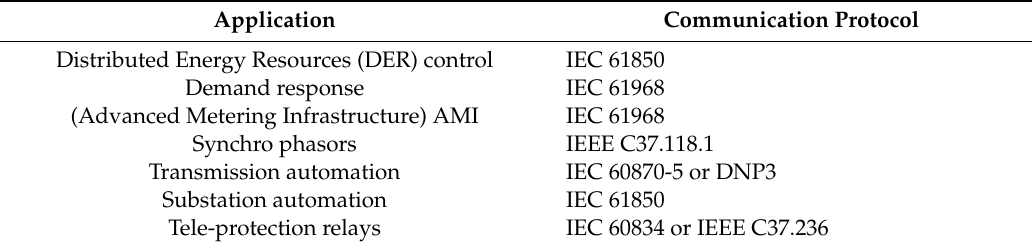
Table 5. Communication protocols